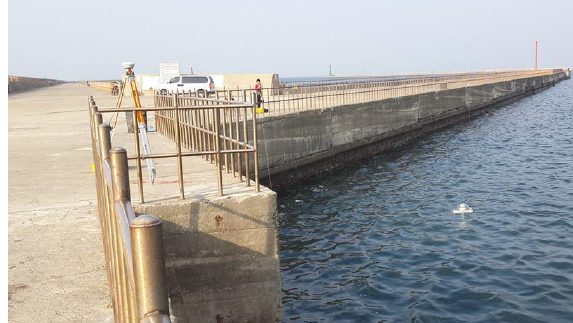
Figure 5. In-situ arrangement of experiments in Anping Harbor.